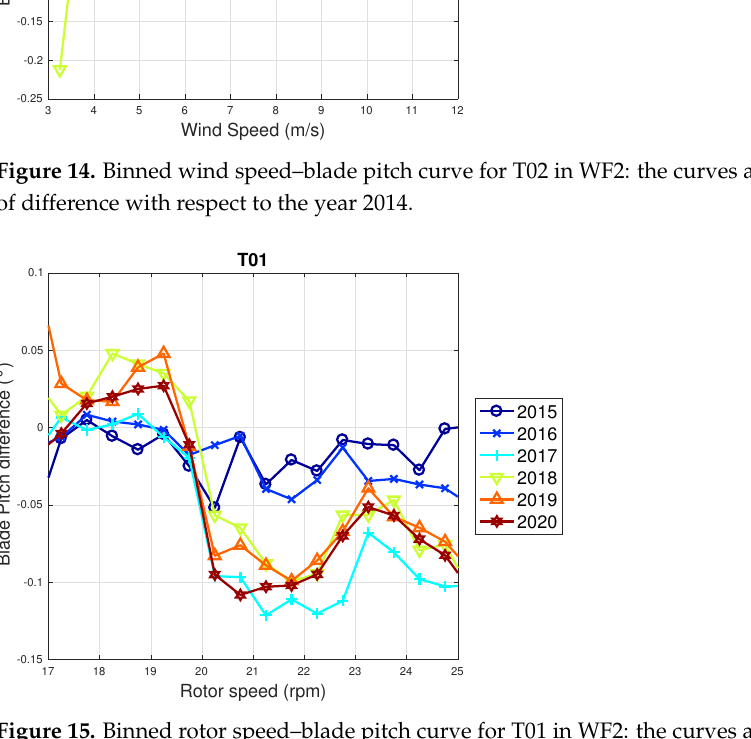
Figure 15. Binned rotor speed–blade pitch curve for T01 in WF2: the curves are reported in the form of difference with respect to the year 2014.